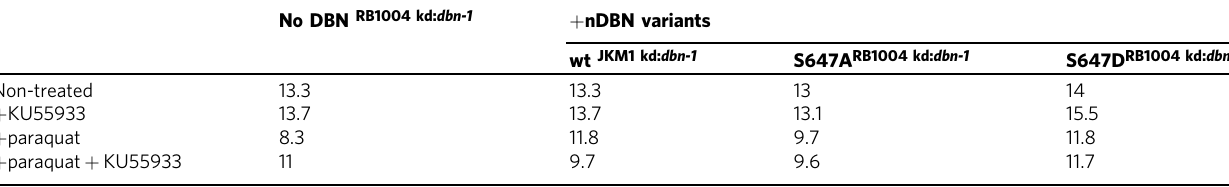
Table 2 Median half-life data of Δ dbn-1 , nDBN, nDBNS647A or nDBNS647D treated with paraquat and/or ATM inhibitor